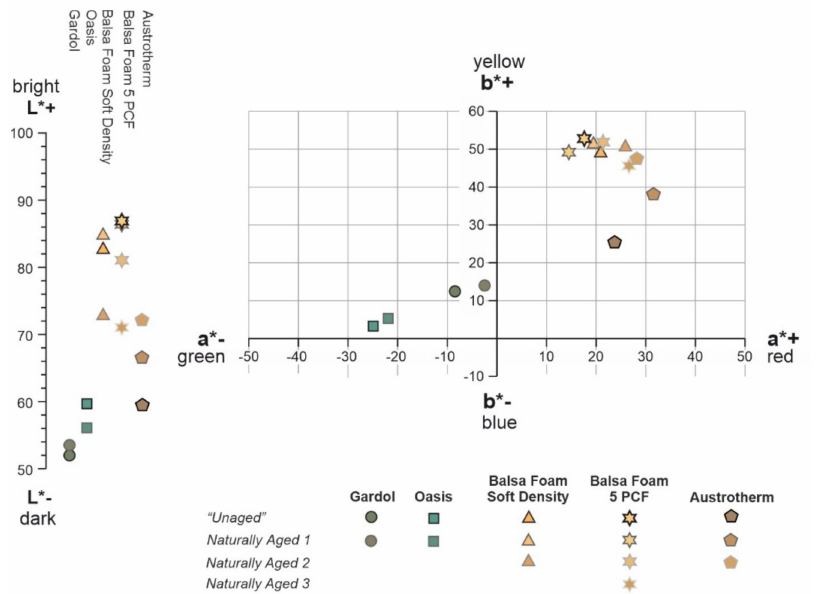
Figure 9. CIELab diagram of the open-cell Oasis and Gardol PF foams as well as of the closed-cell Balsa foam soft density, Balsa foam 5 PCF, and Austrotherm PF foams showing the shifts of their L*, a*, and b*